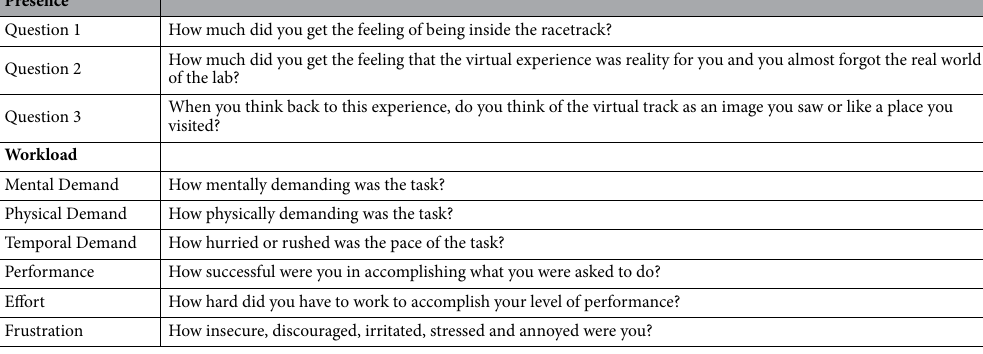
Table 1. Questions assessing the perceived feeling of presence and